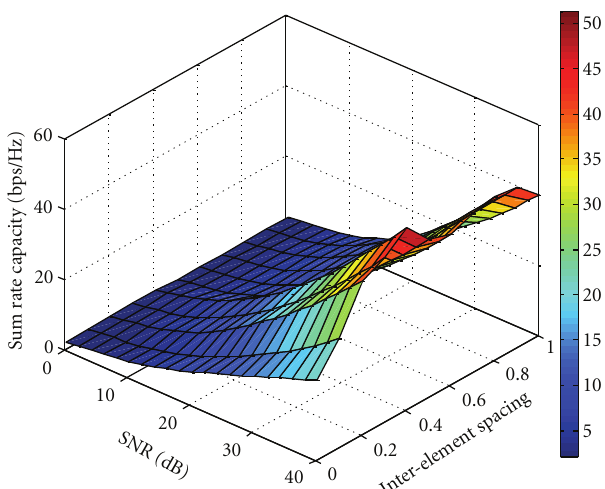
Figure 4: Sum rate capacity with regard to interelement spacing at MSs for a 2 × (3 × 6) multiuser MIMO system with and without mutual coupling taken into account.